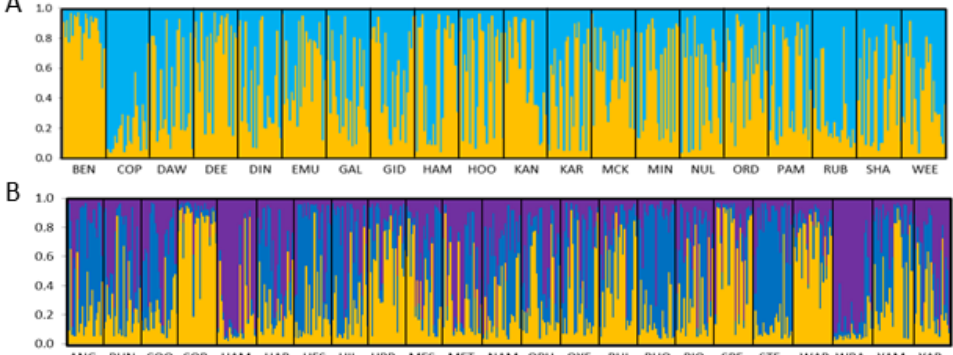
Figure 4. STRUCTURE analysis based on nuclear microsatellite data for ( A ) C. hamersleyana (K = 2) and ( B ) A. pruinocarpa (K = 3). Samples are ordered by population and each vertical bar represents an individual, with colours representing the proportion of assignment to each of the K genetic clusters.